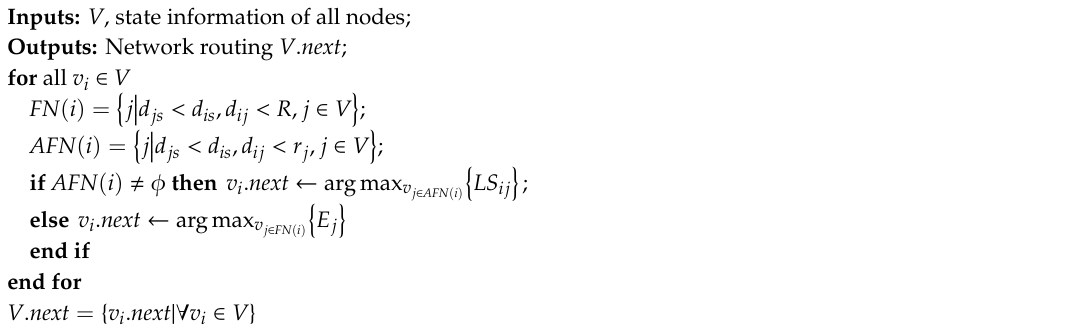
Algorithm 2. Routing setup and update strategy of the autonomous load regulation mechanism-based energy balanced routing algorithm (ALRMR).